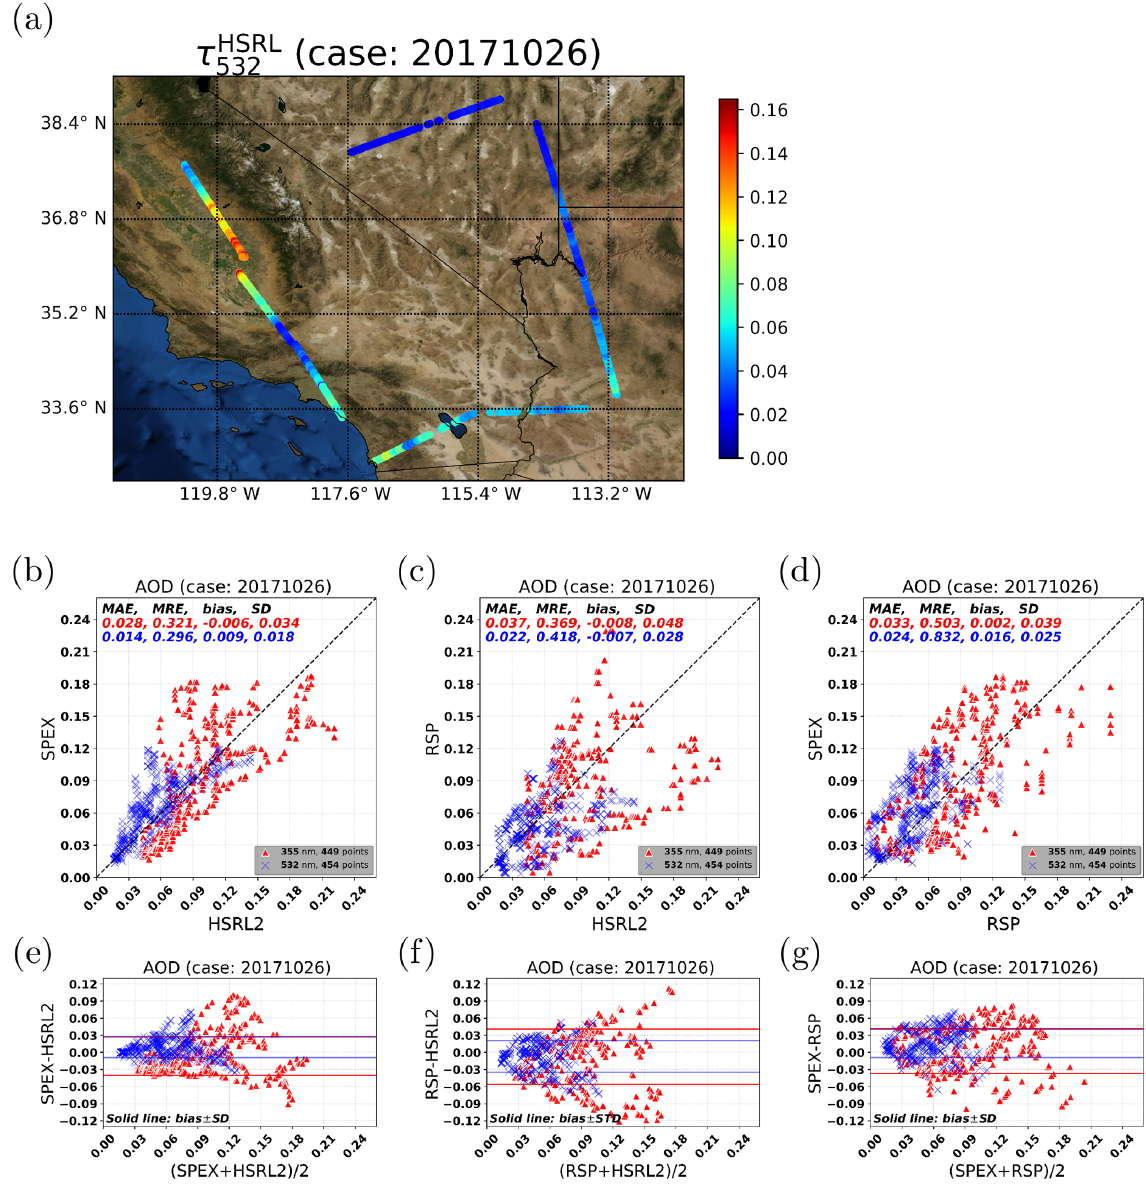
Figure 5. Comparison with HSRL-2 from 26 October 2017 (low AOD case) for AOD (355 and 532nm) between SPEX and RSP retrievals. (a) HSRL-2 AOD colocation with SPEX and RSP. (The map is generated using Python’s basemap package and its ArcGIS image service ESRI_Imagery_World_2D.) (b) SPEX AOD comparison with HSRL-2. (c) RSP AOD comparison with HSRL-2. (d) SPEX AOD